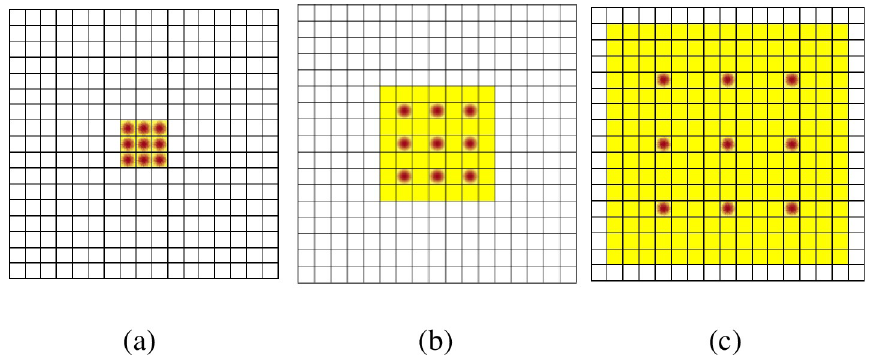
Fig 2. Schematic diagram of the atrous